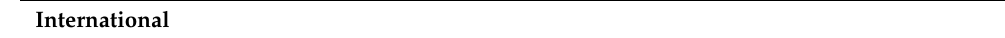
Table 1. Pediatric anesthesia